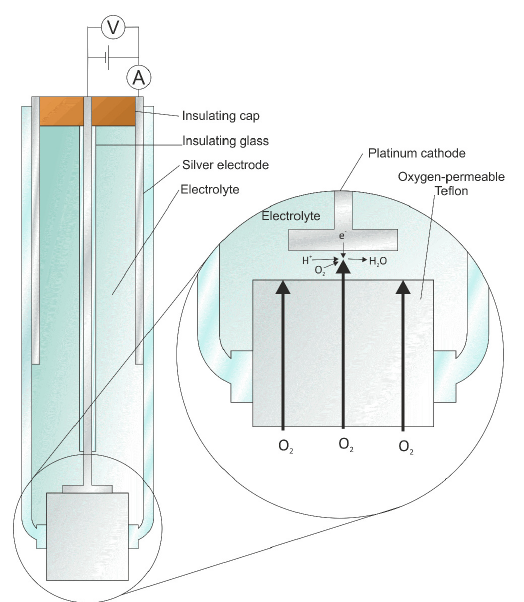
Figure 2. Schematic representation of the glucose biosensor invented by Clark and Lyons